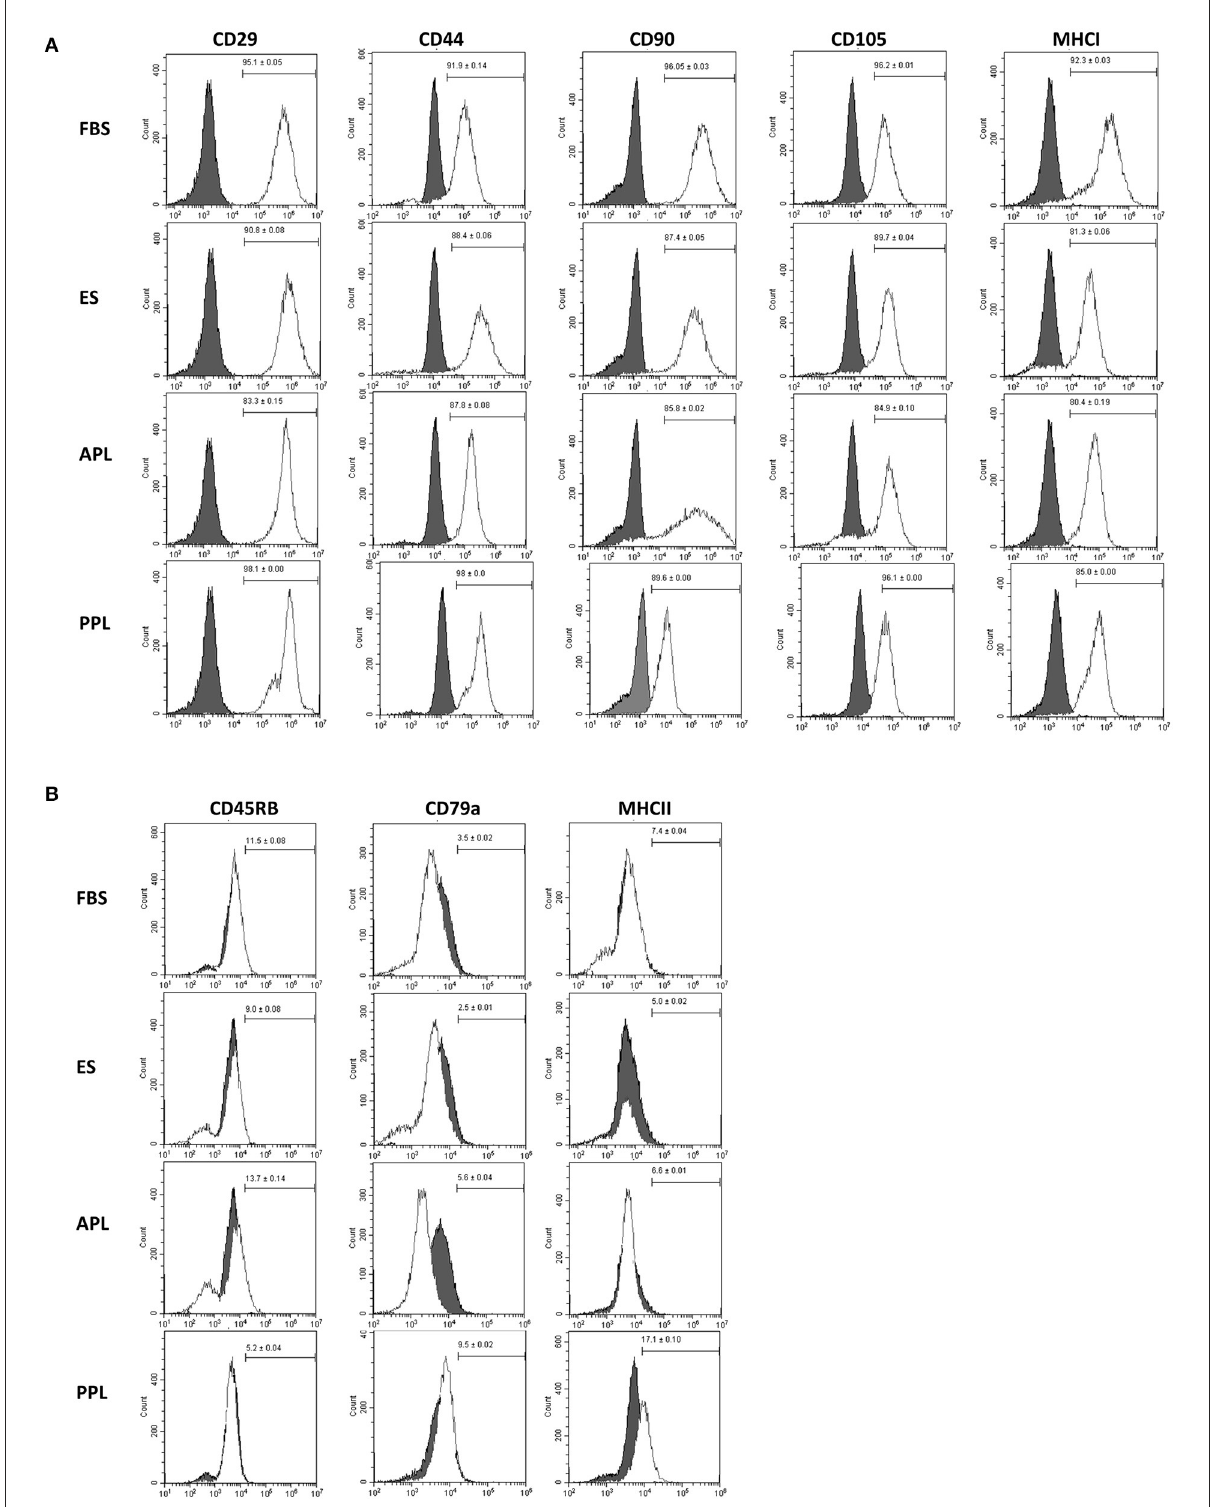
FIGURE3 Characterization of P3 BM-MSCs cultured in FBS, APL, PPL, and ES supplemented media using flow cytometric quantification of cell surface marker expression. (A) Expression of inclusion markers in BM-MSC populations and (B) expression of exclusion markers in BM-MSC populations. The gray histograms represent isotype controls and white histograms represent respective cell surface marker staining. The mean ( ± SEM) percentage of positive cells, obtained from 6 horses with each horse providing 2 experimental replicates, is in the right corner of each histogram. The histogram is a representative result of these replicates. FBS, fetal bovine serum; APL, autologous platelet lysate; PPL, pooled platelet lysate; ES, equine